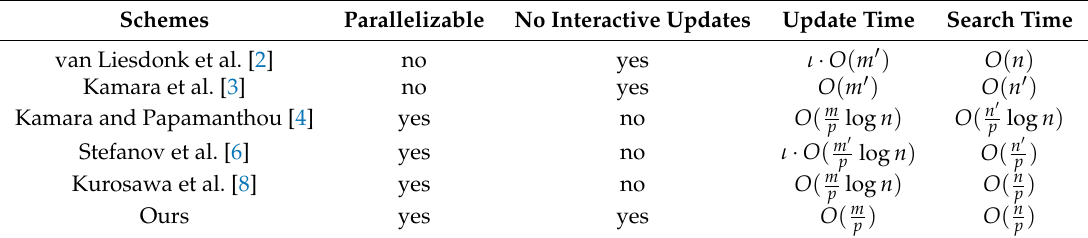
Table 1. Comparison of different dynamic searchable symmetric encryption (DSSE) schemes. Let n be